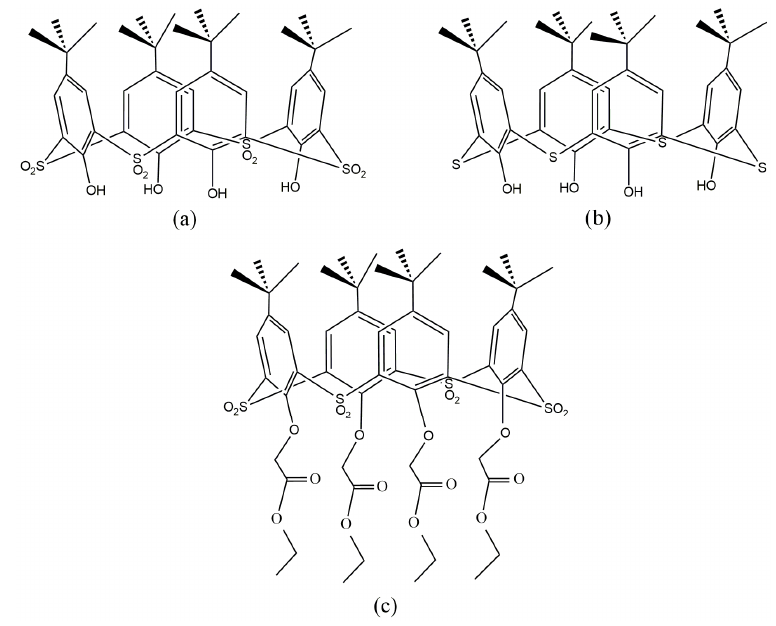
Figure 1. Structures of ( a ) р ‐ tert ‐ butylsulfonylcalix[4]arene (SC4A); ( b ) р ‐ tert ‐ butylthiacalix[4]arene (TC4A); and ( c ) р‐ tert ‐ butylsulfonylcalix[4]arene tetraacetate (SC4AOEt).